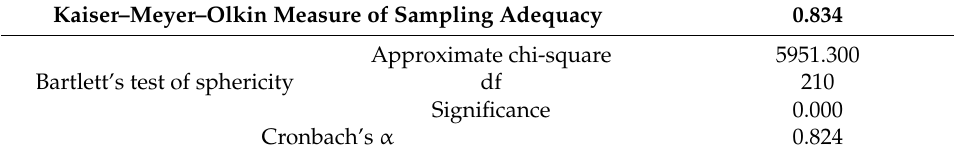
Table 4. KMO and Bartlett’s tests.